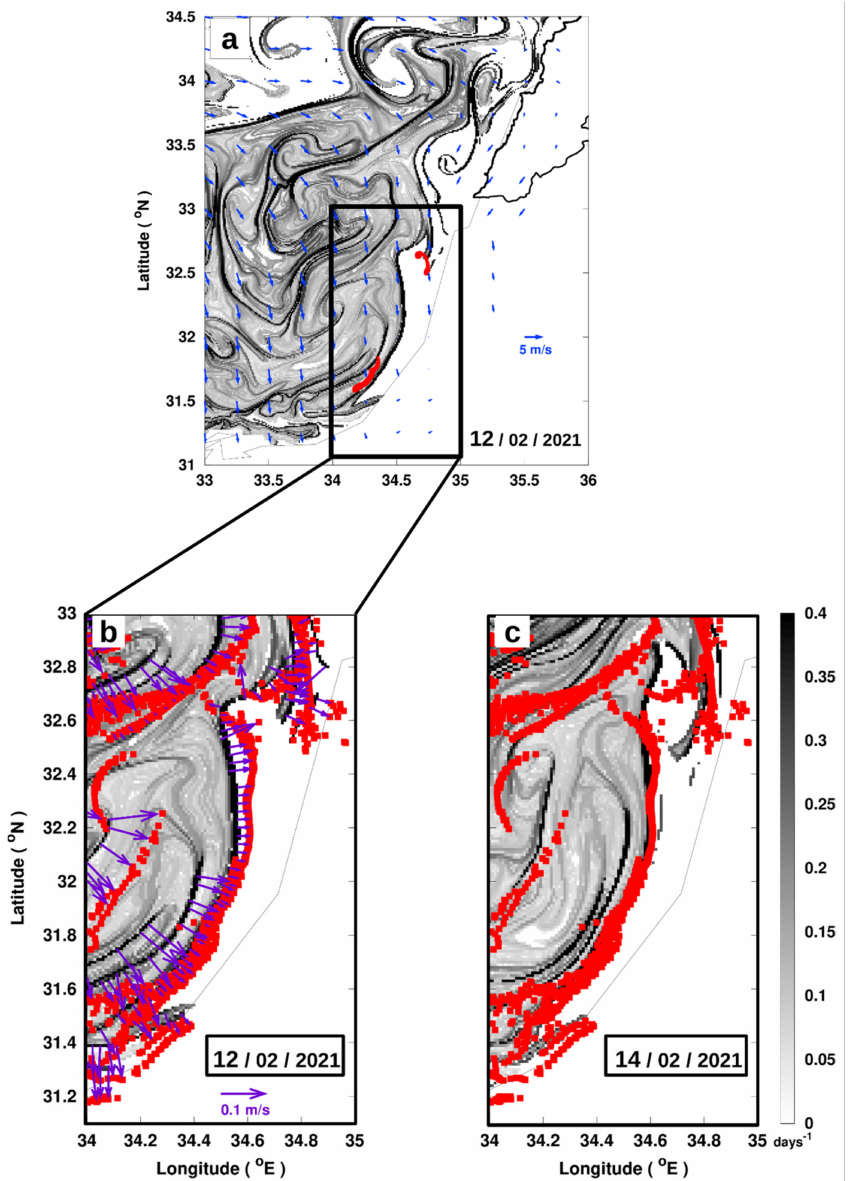
Figure 14. Two-day prediction from the 12th of February using the developed method with the mixed current. The area of pollution is framed in black in panel ( a ). The calculated speeds of front drifting are illustrated in panel ( b ) as purple vectors. The red patterns in panels ( b , c ) represent the resulting fronts after a 2-day prediction since 12 February. The gray-scaled fronts in the background of panel ( b ) refer to those of the 12th of February, while the ones in panel ( c ) are those of the 14th of February. The latter serve for evaluating the placement of the method-derived red